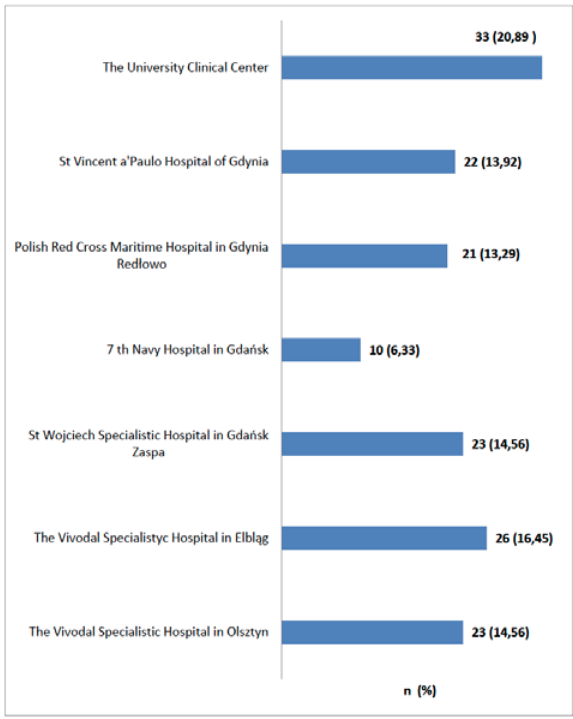
Figure 1: The centres participating in the study (n=158).